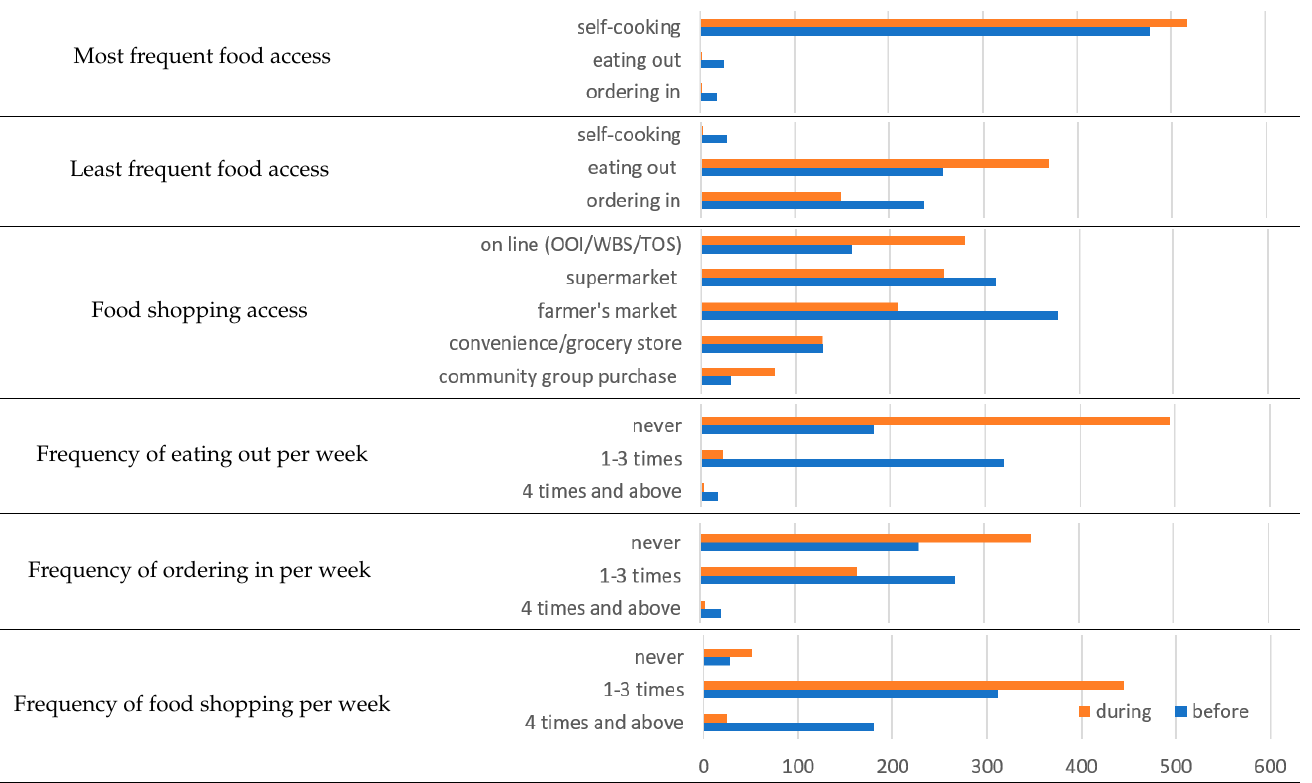
Table 2. Change in food acquisition behavior before and during the pandemic.